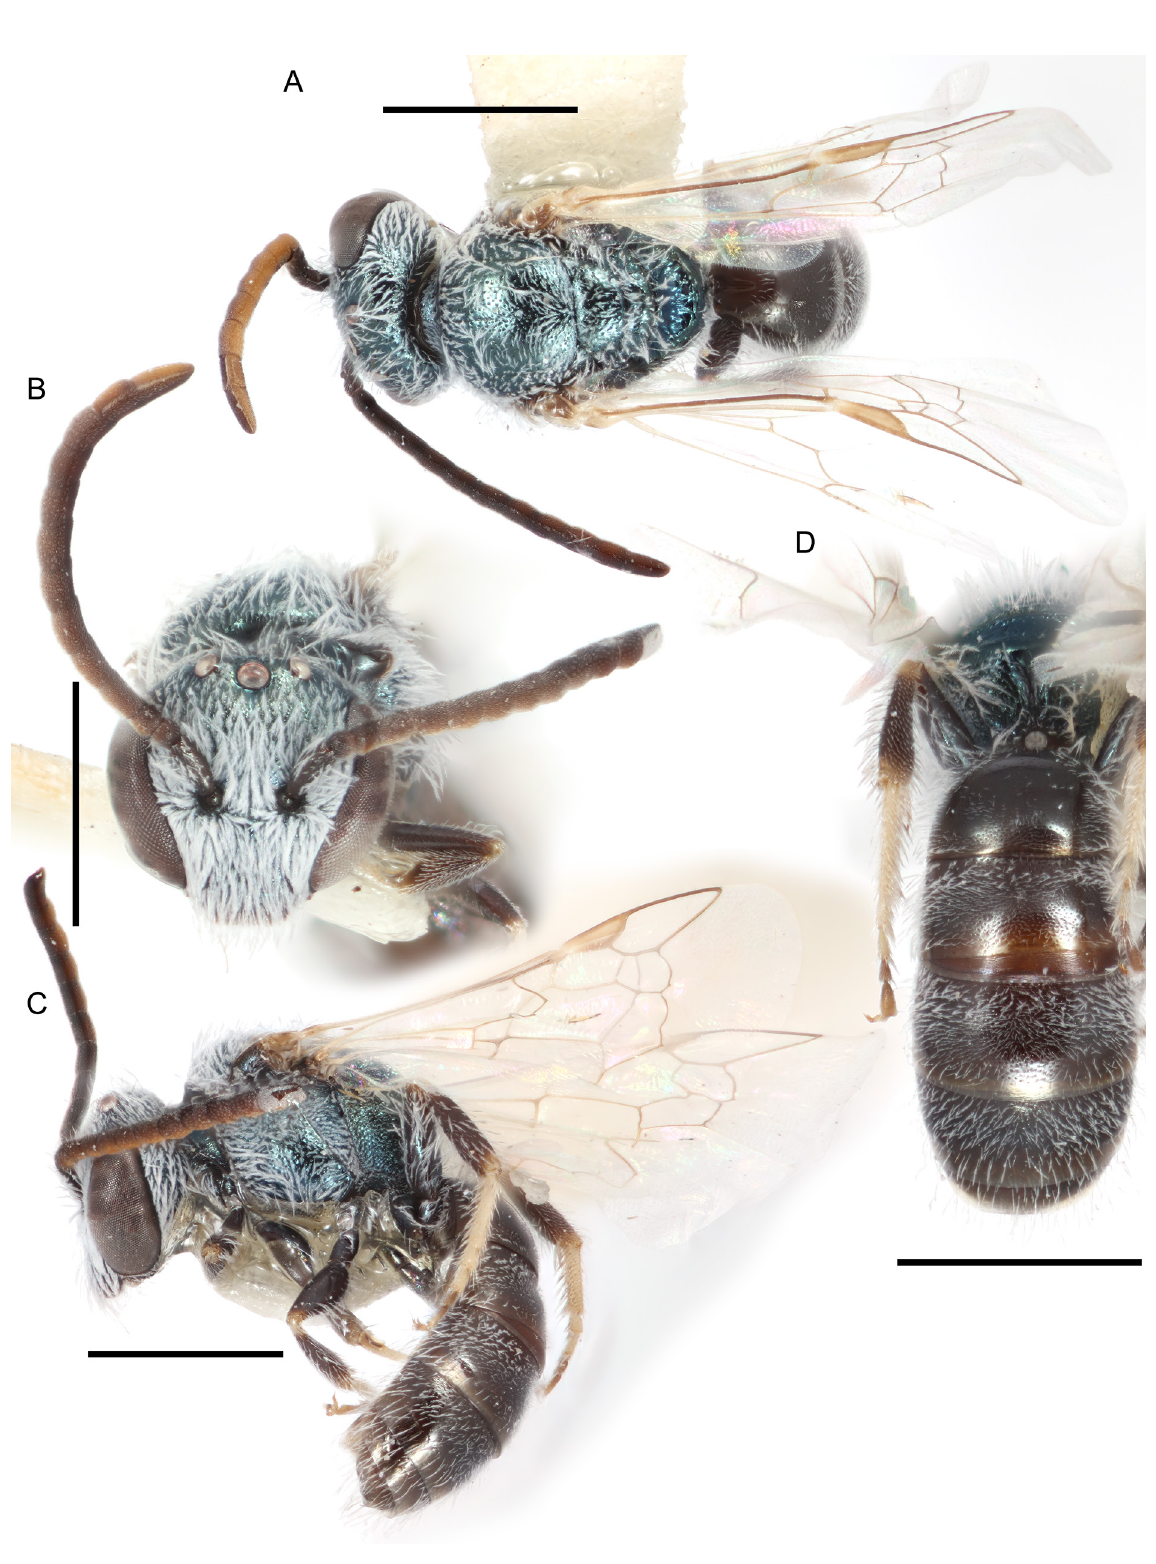
Fig. 47. Lasioglossum ( D. ) julipile sp. nov., ♂. A . Dorsal habitus. B . Face. C . Lateral habitus. D . Propodeum and metasoma. Scale bars: 1